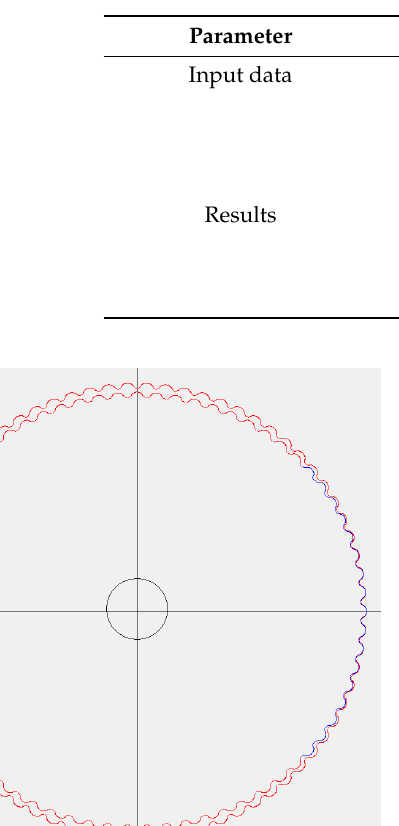
Table 1. Design parameters and results of harmonic gear.